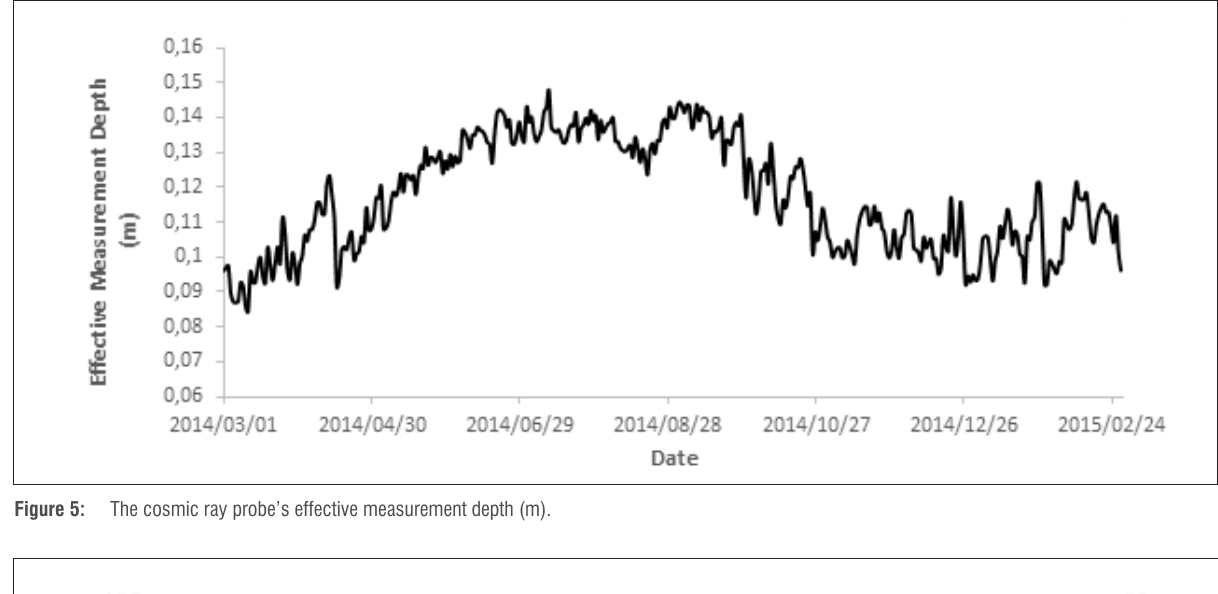
Figure 4: Hourly (grey line) and daily (black line) soil moisture estimates using the calibrated cosmic ray probe.